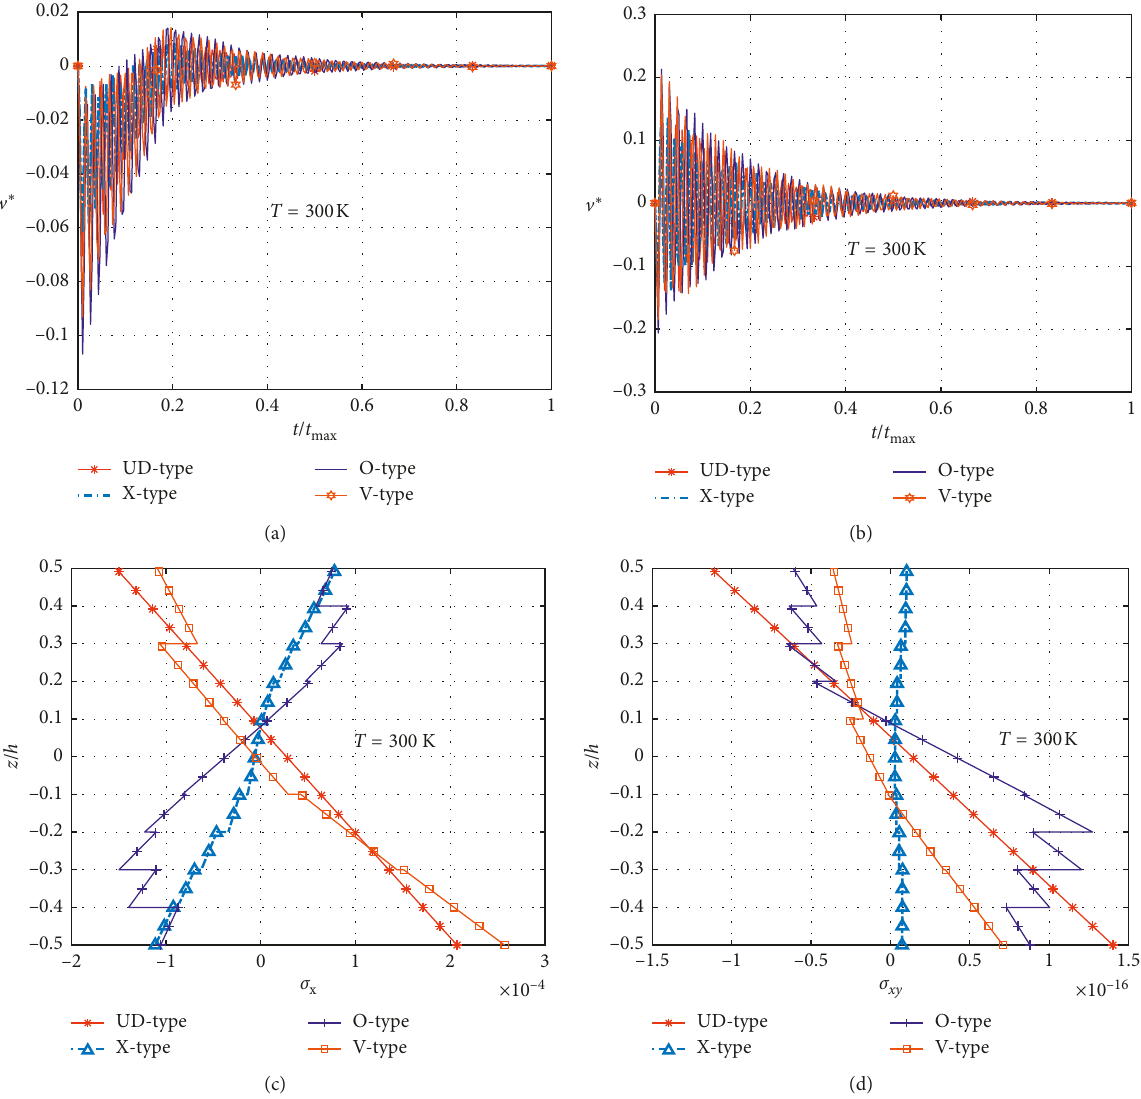
Figure 5: Nondimensional deflection, stress, and velocity of the center point at T (d) stress σ xy